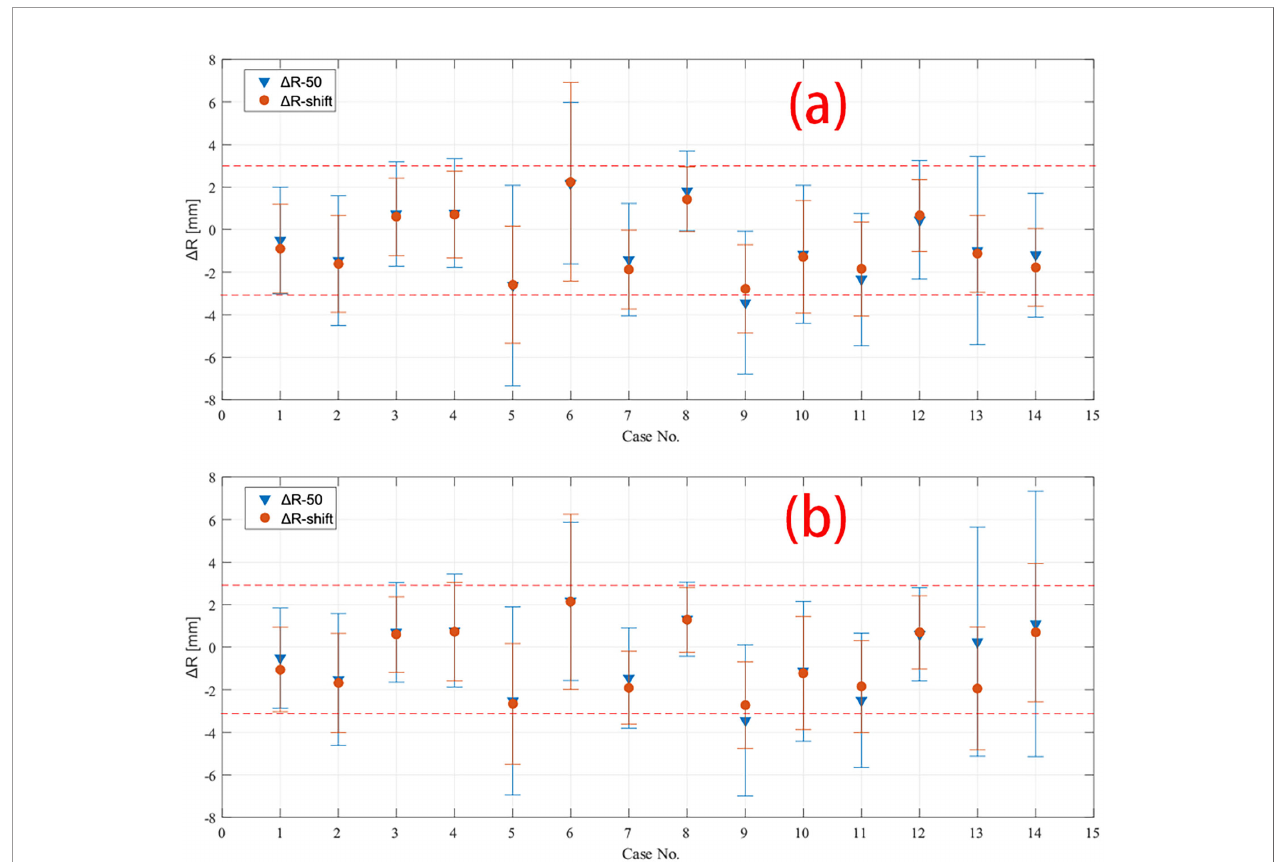
FIGURE 4 | Depth error of all 14 cases calculated by both R 50 and R shift methods in (A) fi eld 1 and (B) fi eld 2. The mean and standard deviation of depth error in CTV region of all cases are plotted except case 7 and 8, which have only data in boost region to be plotted. The red dashed line marked − 3 mm and 3 mm in the